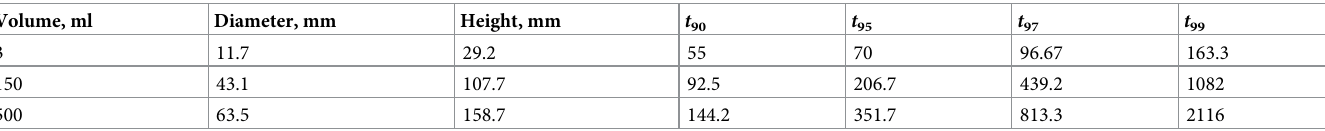
Table 1. Thermal response for three representative cases studied in the 3D container shown in Fig 2B, subject to outer surface cooling from an initial temperature of +10˚C down to -10˚C at a rate of 0.4˚C/min, followed by a temperature hold at -10˚C thereafter, where t s is the time in minutes to reach s response in percent from the full-scale temperature change